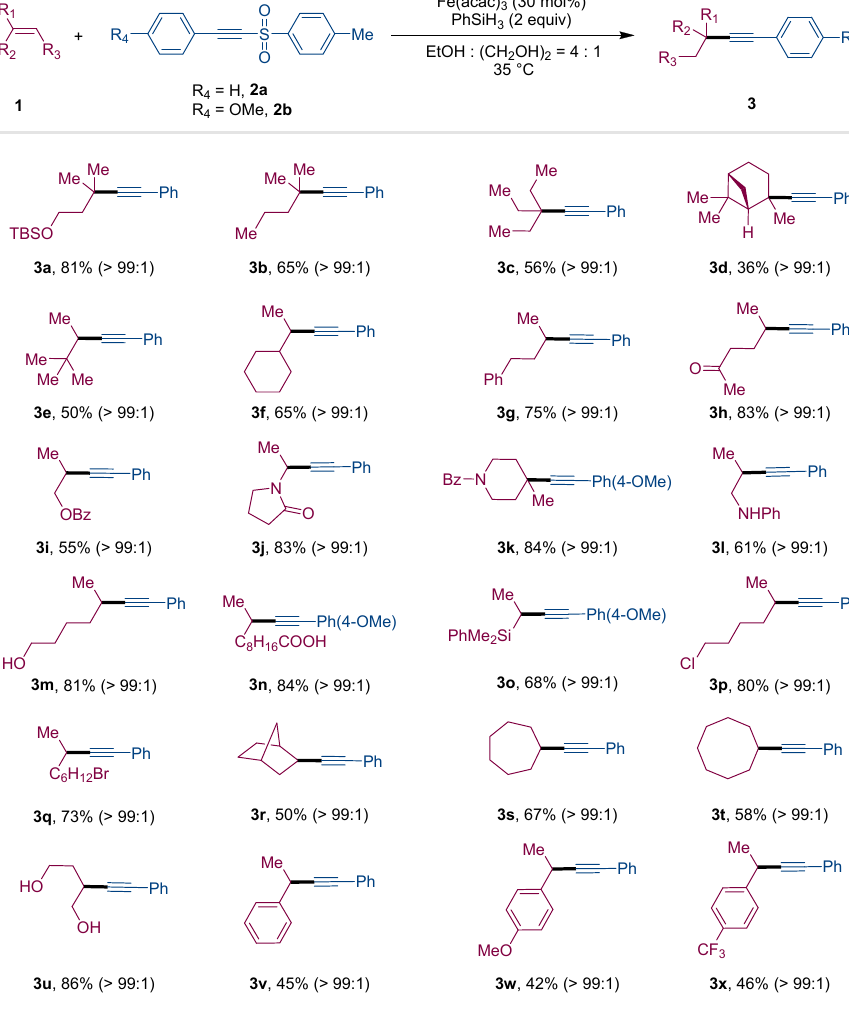
Figure 1. Substrate scope of alkenes a . a Standard conditions: 1 (0.3 mmol, 1.5 equiv), 2a or 2b (0.2 mmol, 1.0 equiv), Fe(acac) 3 (30 mol%), PhSiH 3 (0.4 mmol, 2.0 equiv), in EtOH (0.8 mL) and (CH 2 OH) 2 (0.2 mL) at 35 ◦ C for 12 h, isolated